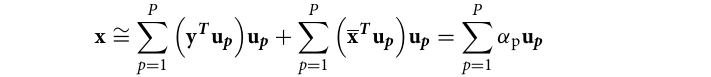
Figure 2. Illustration of the PCA-CGCNN architecture. ( a ) Dimension reduction of DOS vector by principal component analysis (PCA). The coefficients (α) became signal vector. ( b ) Construction of the crystal graph (CG) of NP structures and the structure of the convolutional neural network (CNN) on top of the CG. NP structures are converted to graphs with nodes and edges representing atoms and bonds, respectively. Then, the CNN processes are followed to reflect the local environments of each node in the CG. ( c ) ) Determination of signal vectors. After the CGCNN process, the new graph vector for each atom is fully connected with a signal vector for the DOS representation of each atom by neural networks. ( d ) DOS representation. With the signal vector obtained from the CGCNN, atomic DOS patterns are reconstructed on the basis of PCA. The sum of each atomic DOS pattern produces a total DOS pattern of the